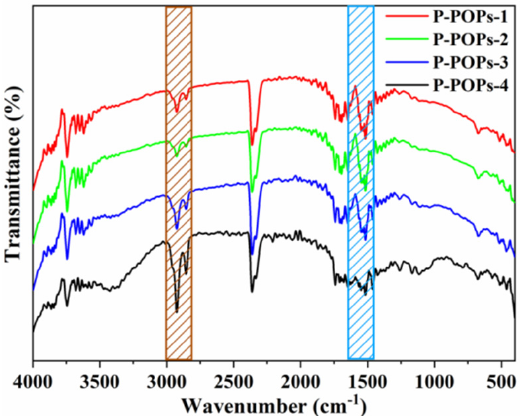
Figure 1. FT-IR spectrum of P-POPs-1, P-POPs-2, P-POPs-3, P-POPs-4. The synthesized P-POPs samples were insoluble in a series of common organic sol- vents such as dichloromethane, methanol, ethanol, ethyl acetate and tetrahydrofuran, indicating their high chemical stability. Moreover, to prove the thermostability of P-POPs, thermogravimetric analysis (TGA) curves are shown in Figure 2. A slight weight loss of about 15~30% from 0 to 200 ◦ C for P-POPs, which may be corresponded to the loss of residual solvent in the polymers or the escape of adsorbed water vapor [35]. At around 330 ◦ C, the weight increases on the thermogravimetric curve possibly due to a small amount of aluminum resulting from the AlCl 3 catalyst remained in the polymers, which may be converted into Al 2 O 3 or other Al oxides after burning in the air. Importantly, P-POPs had no significant degradation below 330 ◦ C and the dramatic weight loss was about 450 ◦ C, which indicated their high thermal stability.